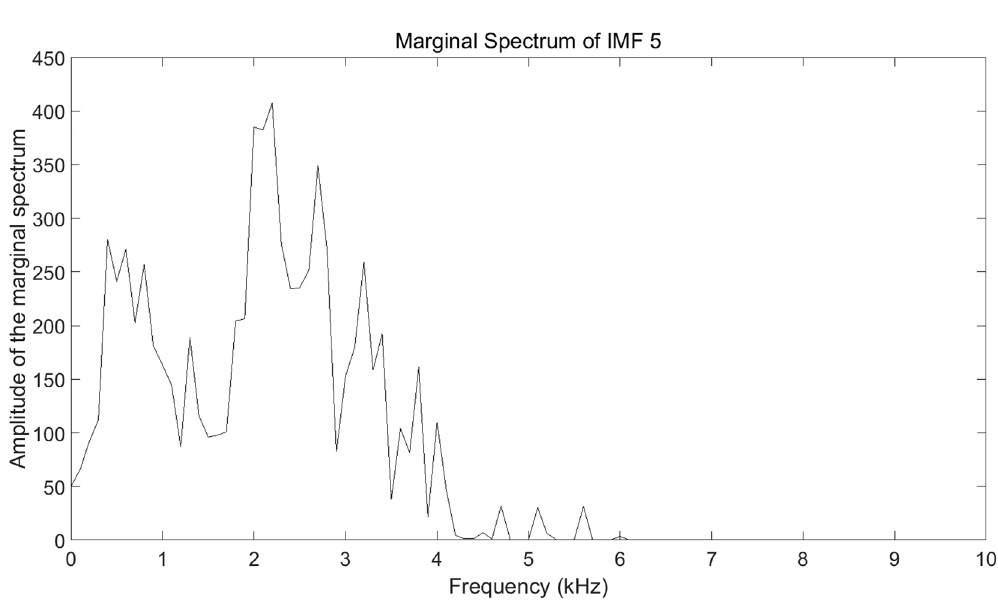
Figure 13. The marginal spectrum of IMF